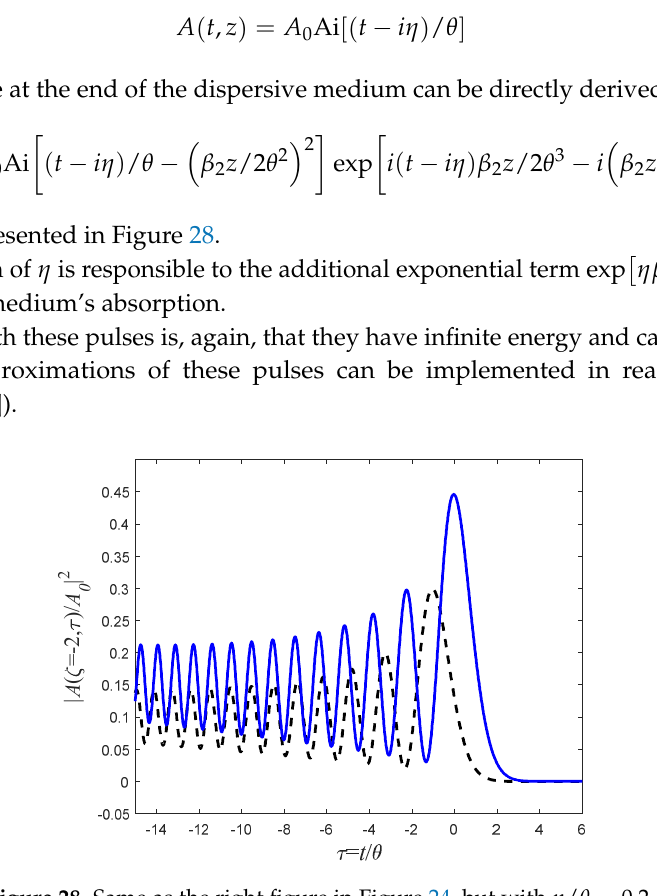
Figure 28. Same as the right figure in Figure 24, but with η / θ =